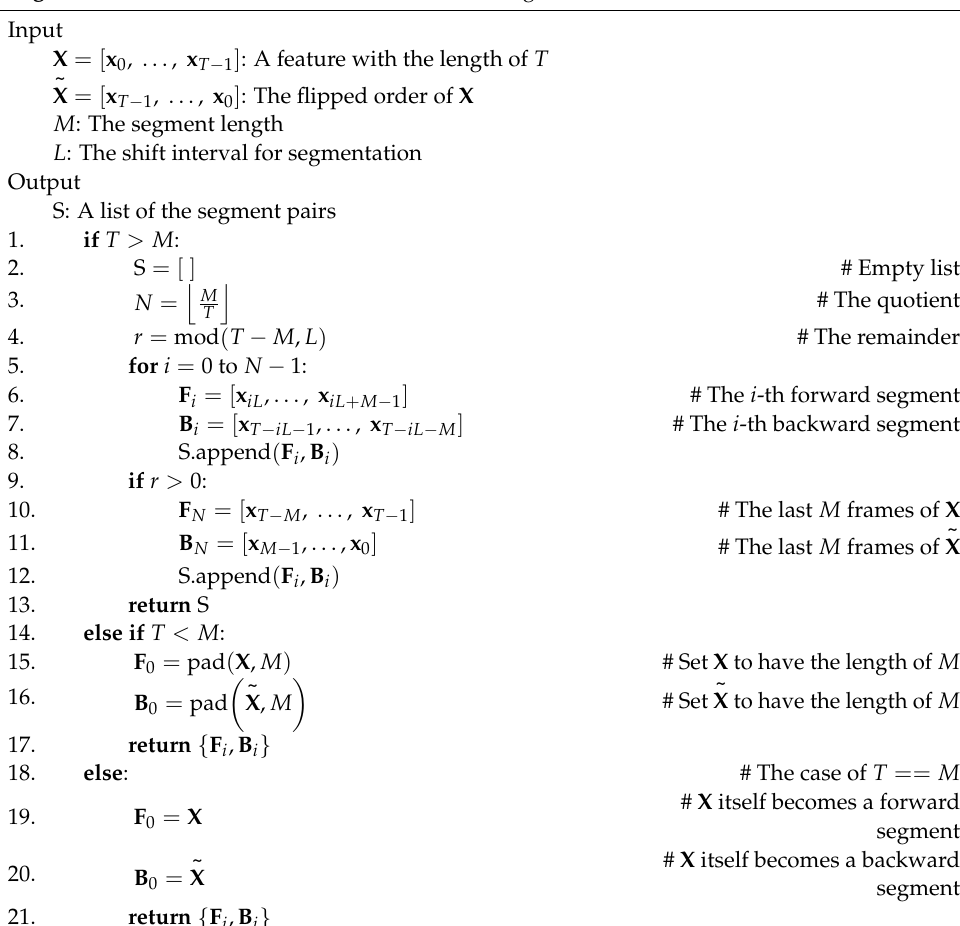
Figure 2. The overview of the proposed bidirectional feature segmentation when ( left ) M < T and ( right ) M > T , where X = [ x 0 , . . . , x T − 1 ] is a feature with the length of T , M is the segment length, and F i and B i are the i -th forward and backward segments, respectively. Algorithm 2 Pseudocode of Bidirectional Feature Segmentation